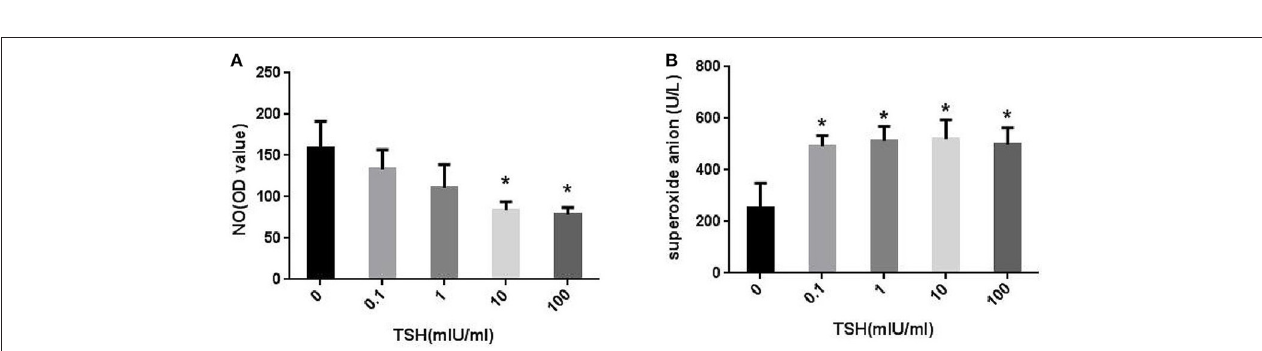
FIGURE 4 | Effect of TSH on NO and superoxide anion levels in vitro . HUVECs were stimulated by different concentrations of TSH (0, 0.1, 1, 10, and 100 mIU/ml) for 24h. (A) NO levels in HUVECS and the OD values of NO were adjusted by concentrations of protein extracted from HUVECs; (B) Superoxide anion levels in the supernatant; Data were obtained from three separate experiments. * P < 0.05, when compared to the control.